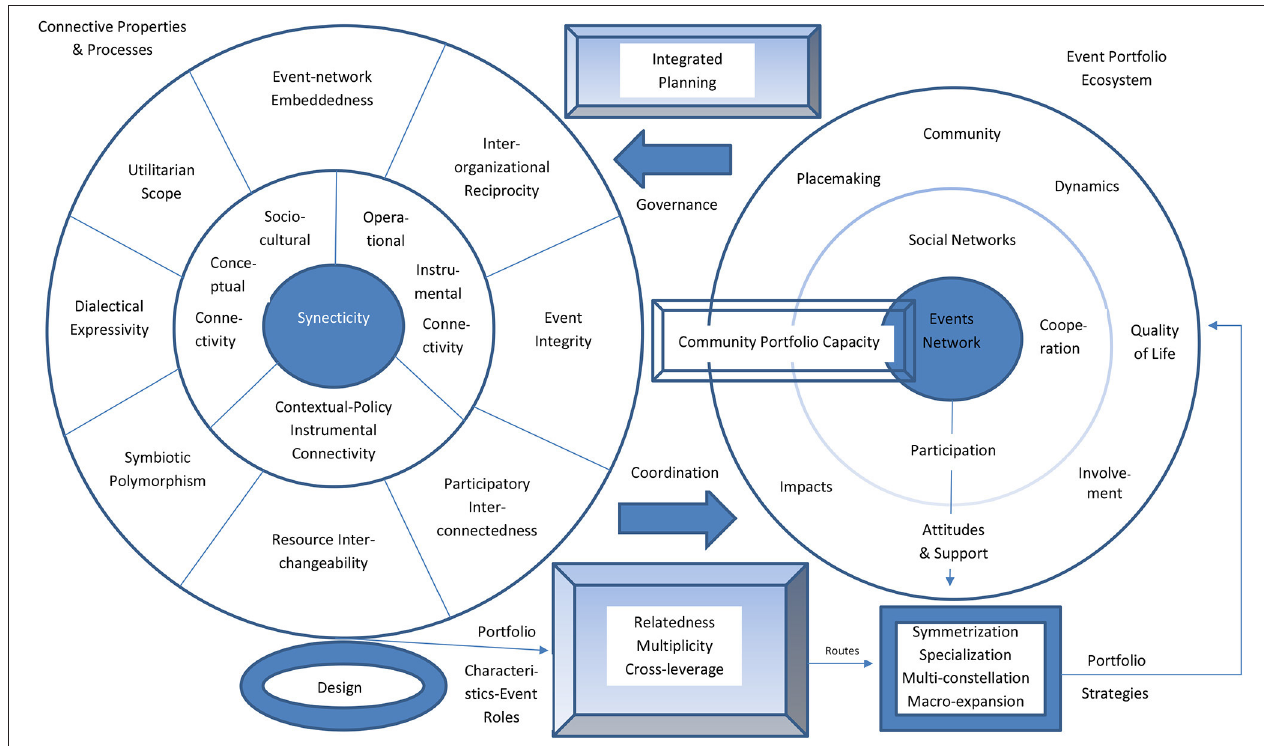
FIGURE 1 | Morphosynthesis of event